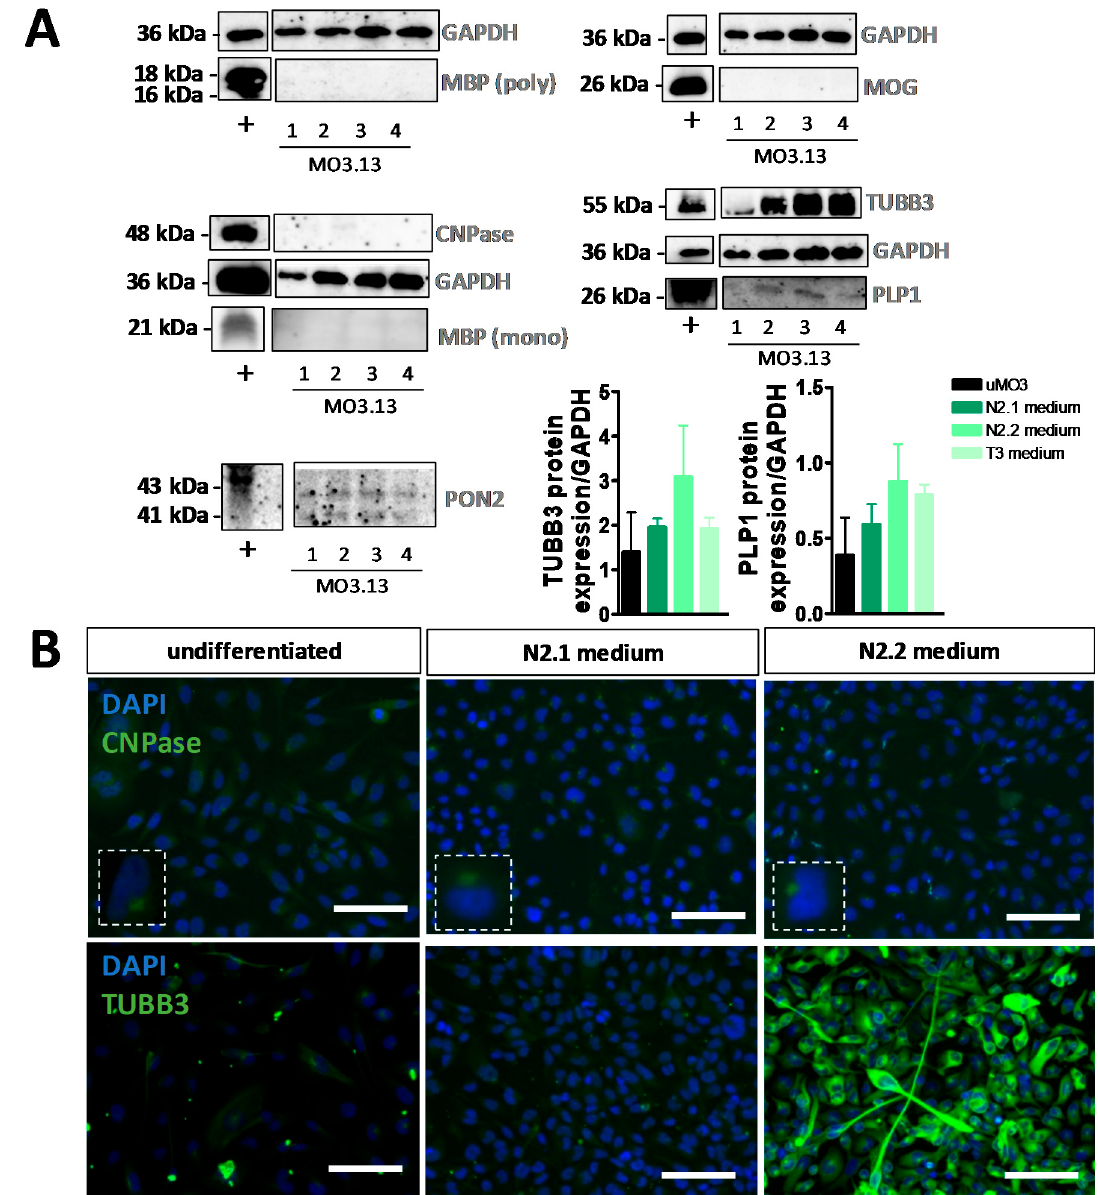
Figure 4. Analysis of protein expression in undifferentiated and differentiated MO3.13 cells. ( A ) Western